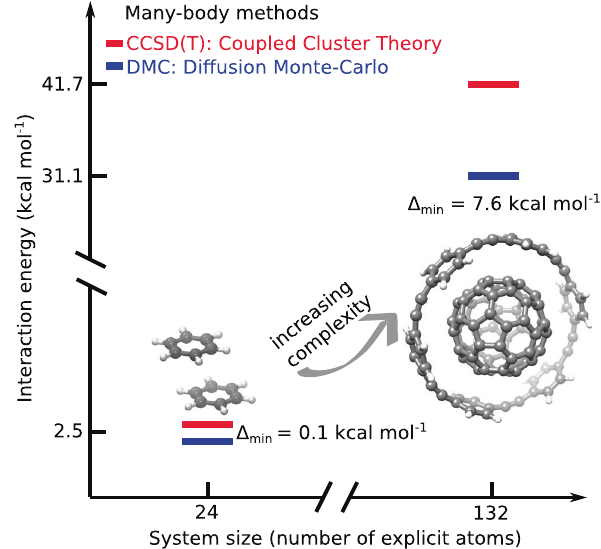
Fig. 1 CCSD(T) and FN-DMC interaction energies for a medium and a large dimer. It can be seen that the interaction energy increases by a factor ~10, near-linearly with the size of the system, whereas the corresponding disagreement between CCSD(T) and FN-DMC increases by a factor of